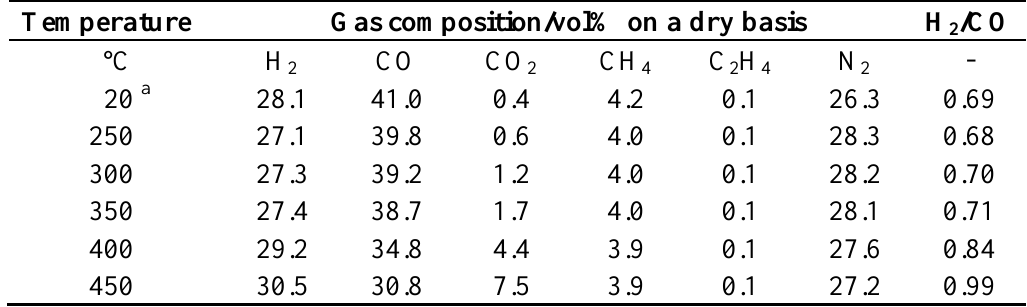
Table 2. Effect of temperature on composition of gas leaving the